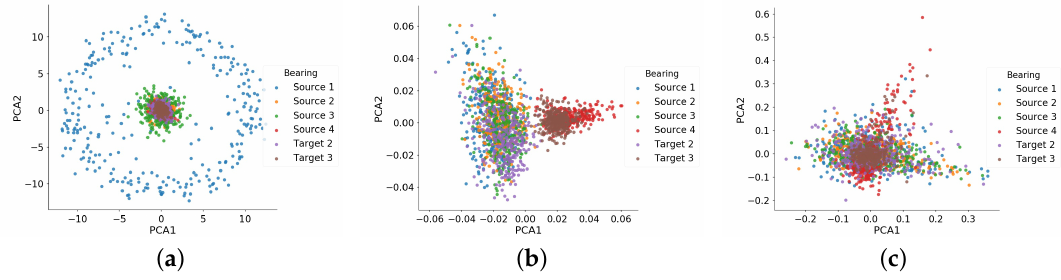
Figure 17. Feature distribution of six training bearings with ( a ) raw time signal, ( b ) HHT marginal spectrum, and ( c ) the common features extracted by domain adaptation